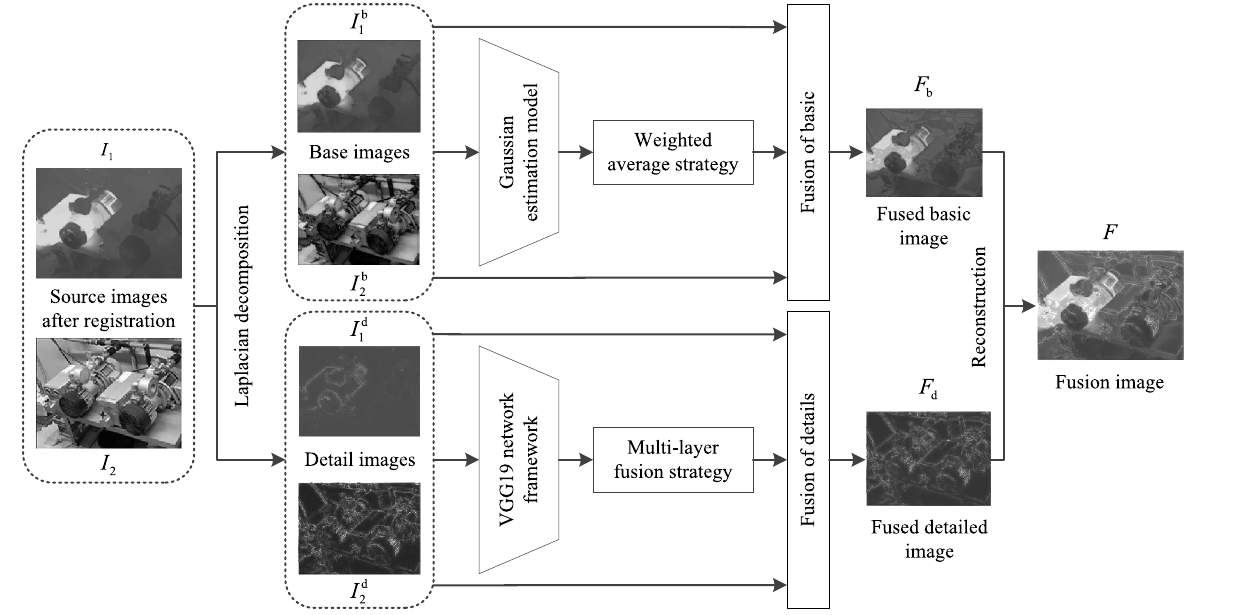
Figure 3. The overall framework diagram of the proposed method.